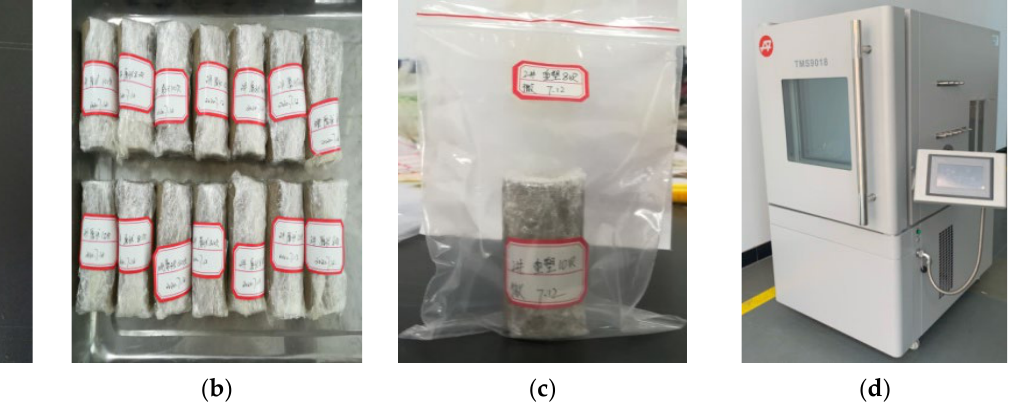
Figure 2. Sample preparation flow chart. ( a ) Wrapped in plastic; ( b ) marked sample; ( c ) sealed sample; ( d ) freeze–thaw cycle test box.